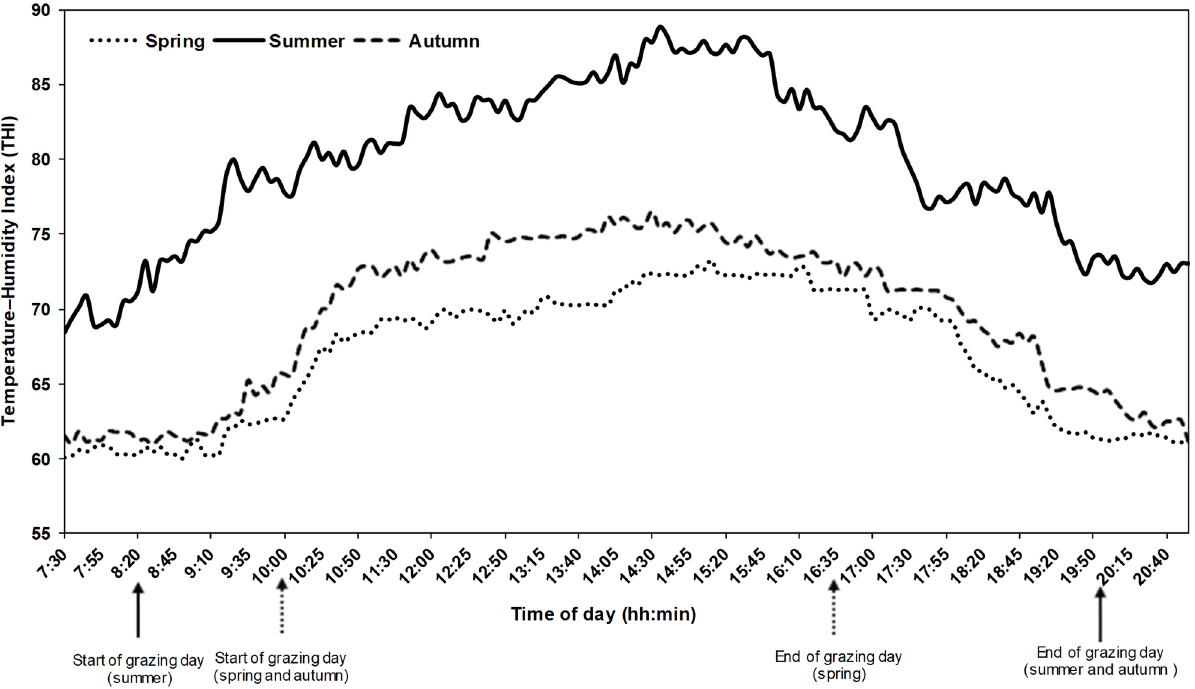
Figure 3. Seasonal changes in the hourly temperature–humidity index during the observation days of goats grazing in a Mediterranean forest rangeland of northern Morocco (local time: GMT +